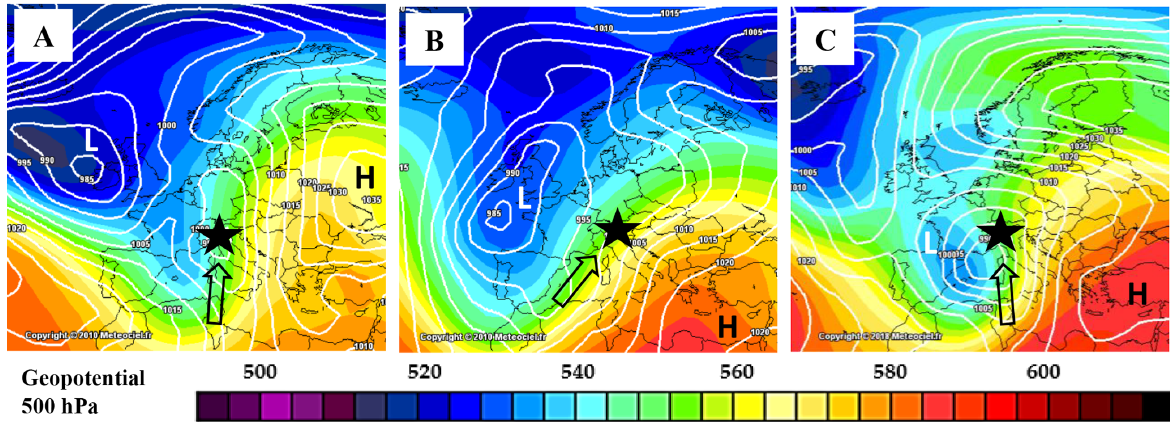
Figure 4. Reanalysis maps from NCEP reporting the sea level pressure and 500hPa pressure (colours) for the 1966 (a) , 2002 (b) , and 2018 (c) events, where the black star is the Sondrio Province position and the black-outlined arrow indicates the incoming southerly flow responsible for huge precipitation enhancement, adapted from © MeteoCiel